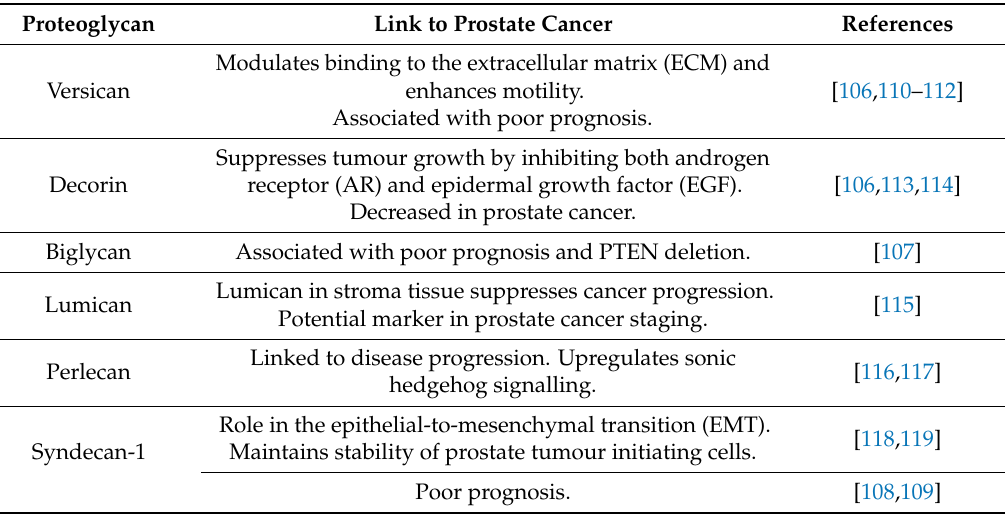
Table 2. Proteoglycans with roles in prostate